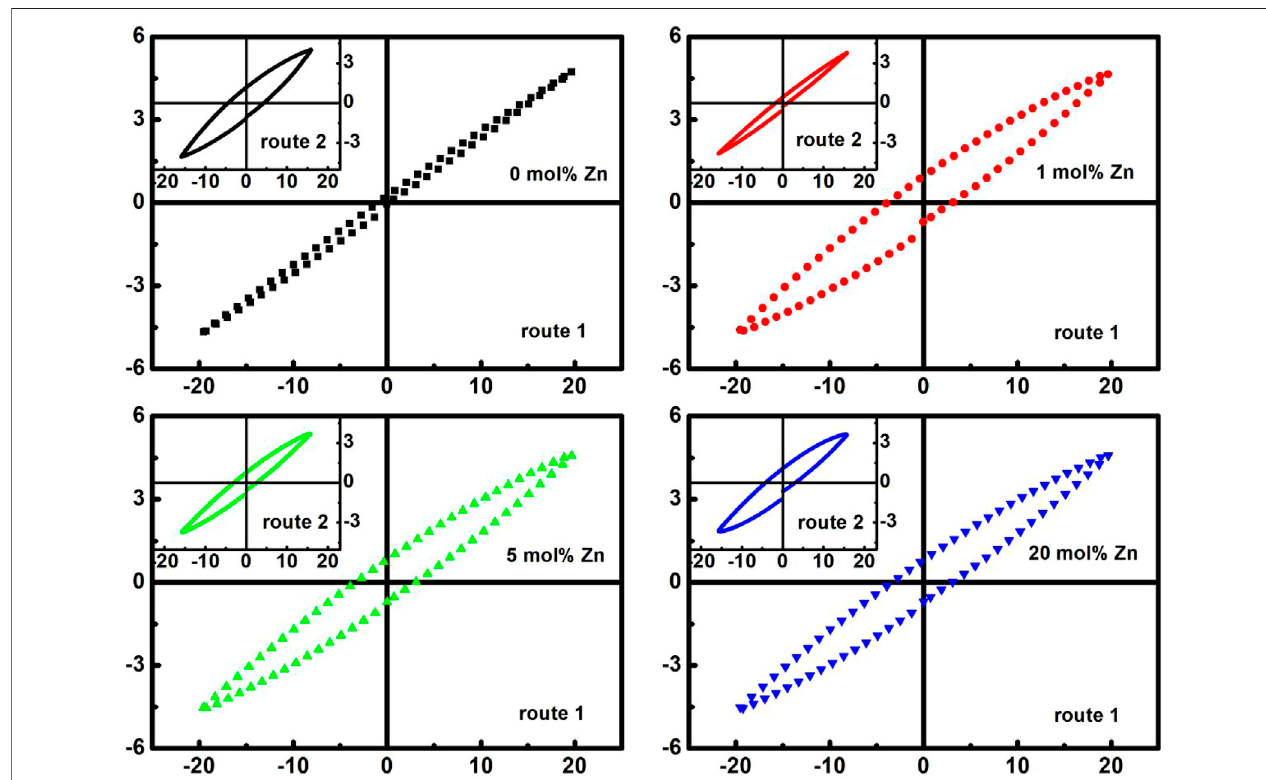
FIGURE2| P-Eloops measured at 150 ° Cand20 kV/mmforCST-ZnOceramics prepared via process route1;theinsets showP-E loopsmeasured at 150 ° Cand 16 kV/mm for CST-ZnO ceramics prepared via process route 2.